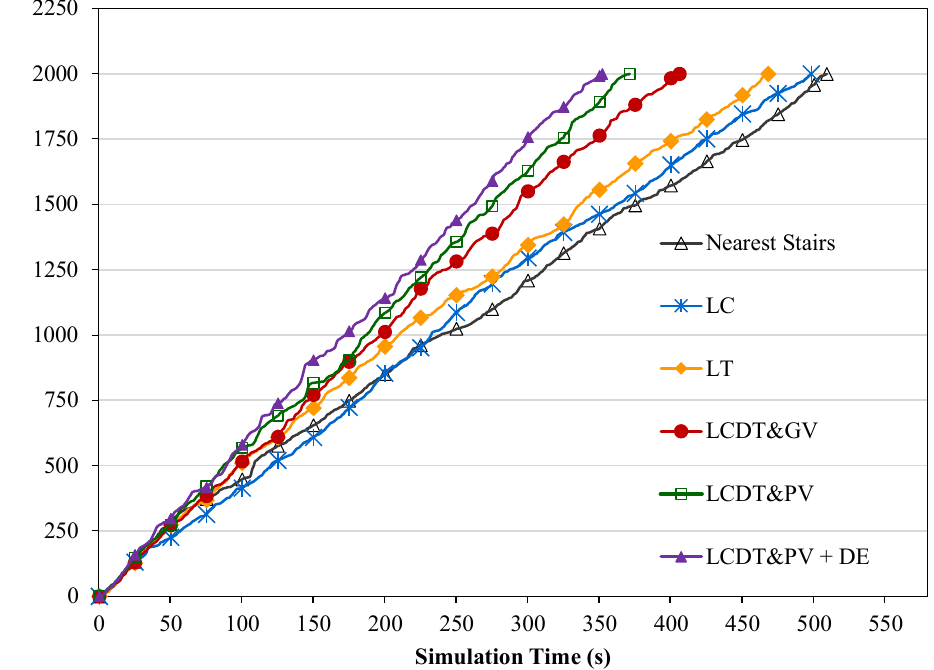
Figure 4. Comparison of the effectiveness between the LCDT&PV and other baseline